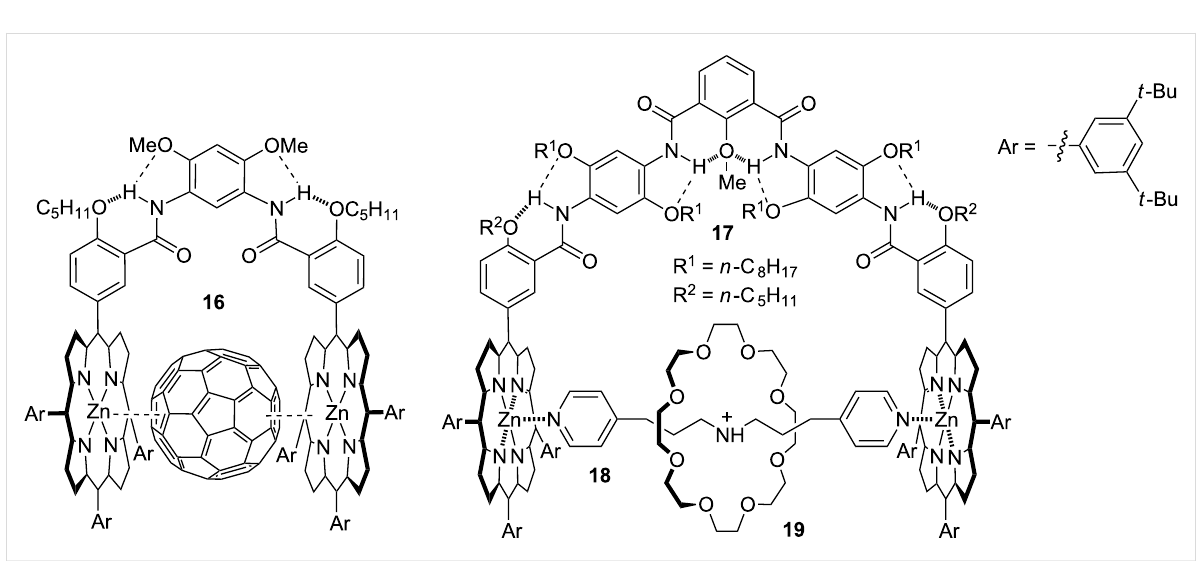
Scheme 8: The structures of complex C